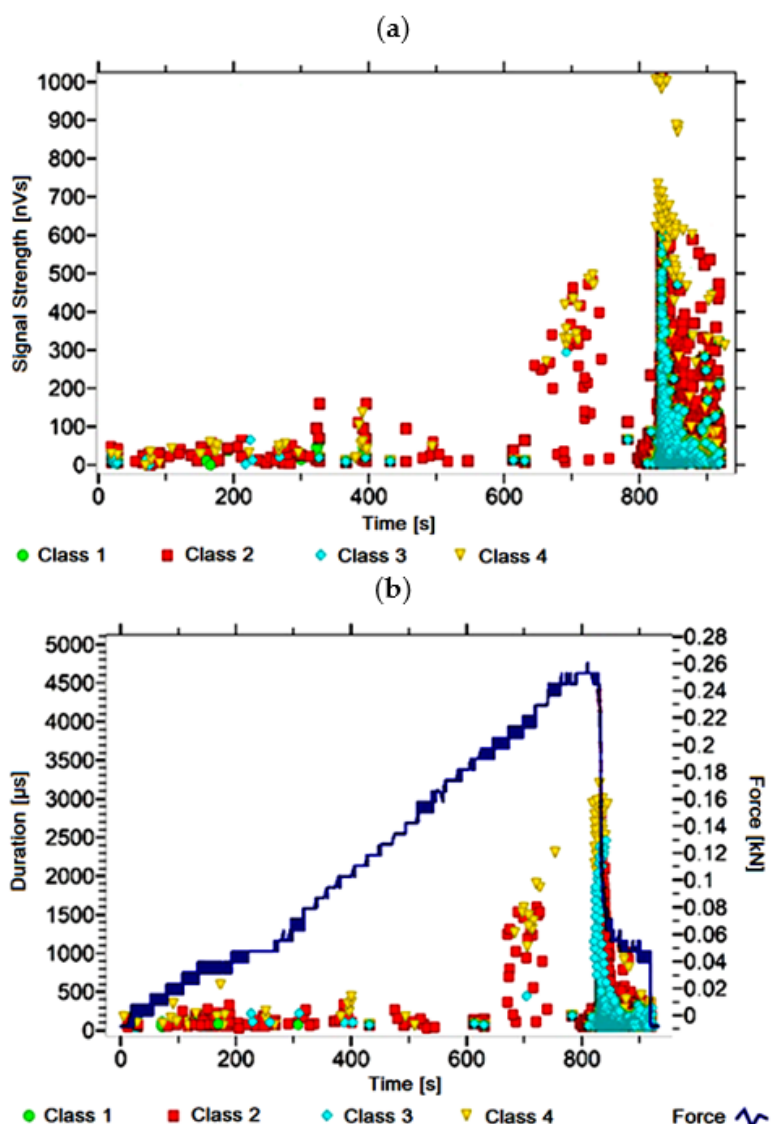
Figure 9. Graphs of acoustic emission signals for an exemplary sample of A 8 series: ( a ) signal strength over time; ( b ) distribution of the duration of the signals over time with the force increment curve.